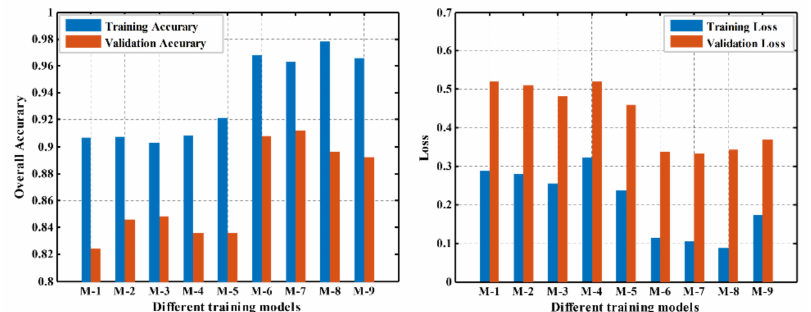
Figure 11. Training and validation accuracy and losses with different training